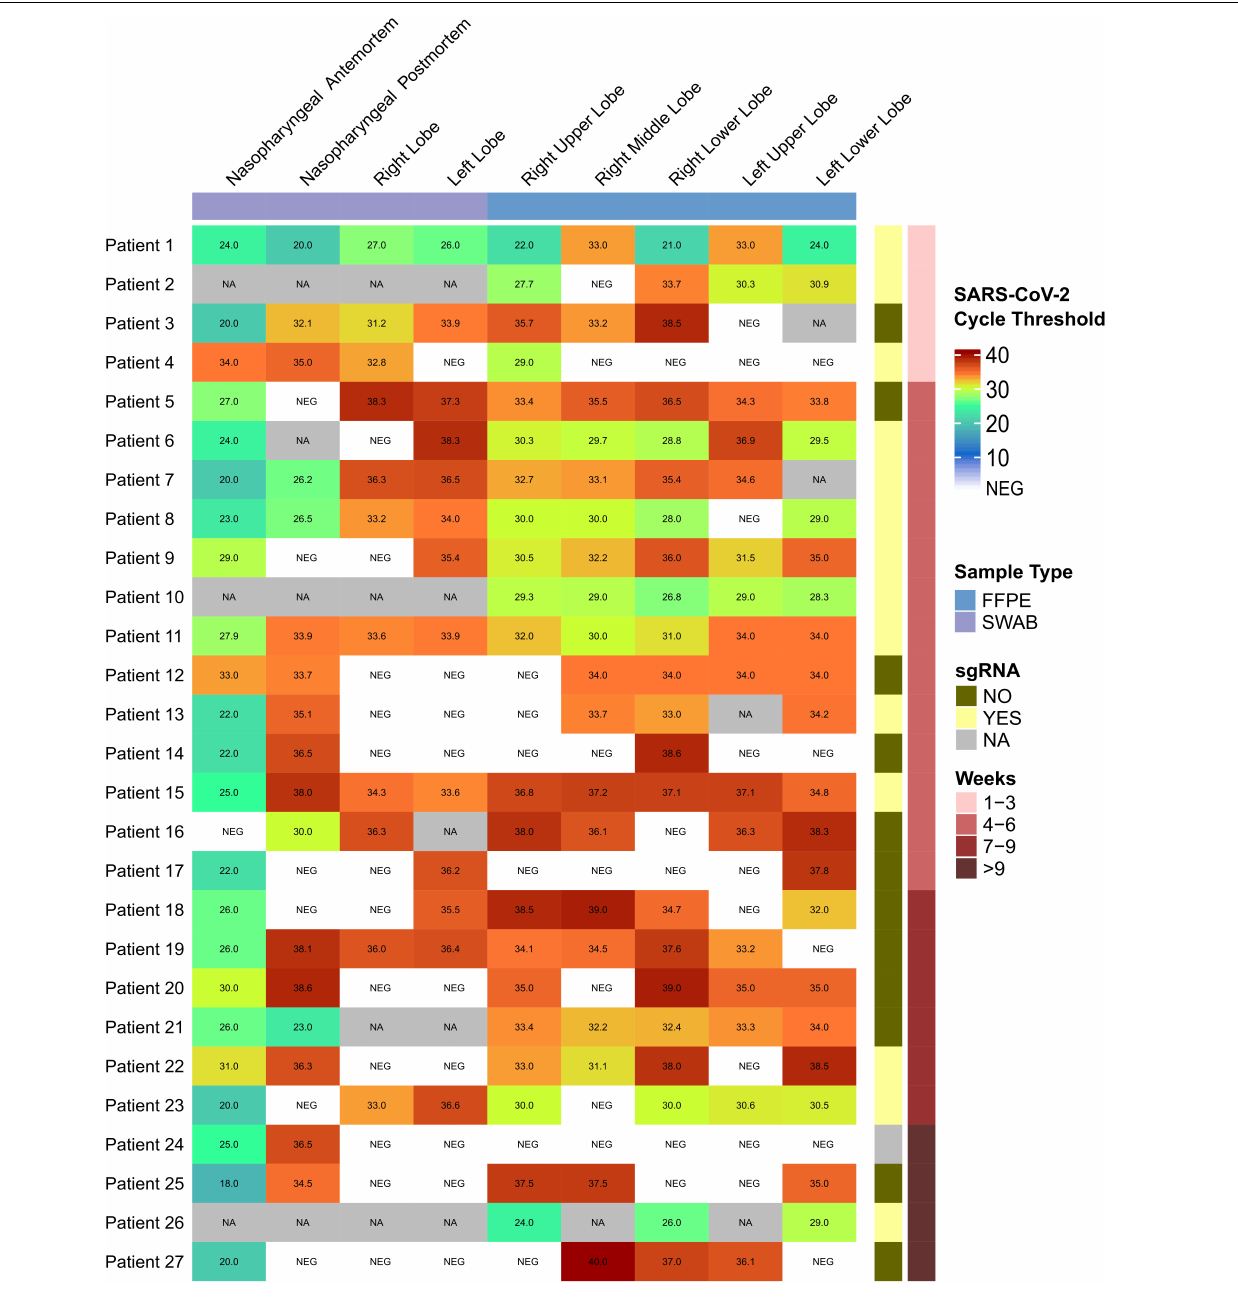
FIGURE 3 | SARS-CoV-2 cycle threshold values heatmap visualization. Upper blue bar indicates sample type (swab or formalin fixed paraffin embedded tissue –FFPE) of nasopharyngeal or lung locations. Right red bar indicates the weeks from onset of symptoms and right yellow bar shows the presence of sub-genomics regions. For antemortem nasopharyngeal swabs, three positive patients did not have the Ct values recorded (NA). One additional patient had a negative result in our hospital, but a positive result in another center. For post-mortem samples, NA indicates no sample available. The infant corresponds to Patient